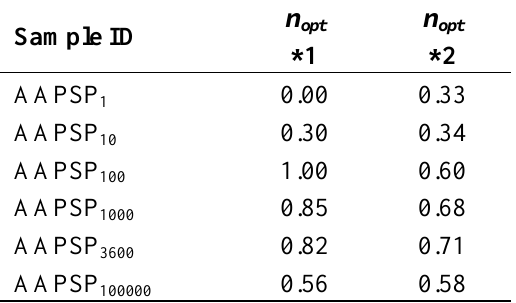
Table 3. Optimum value, n given dipping duration. Condition *1 :   =  =  =   